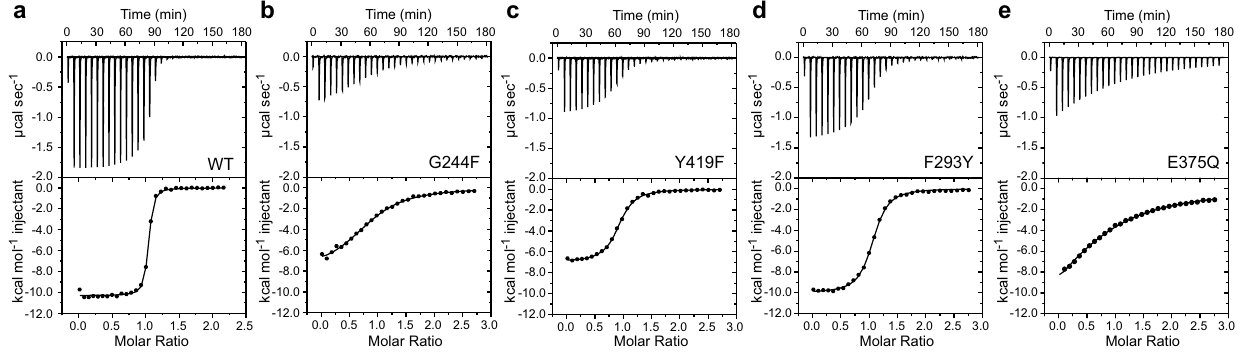
Fig. 3 | Thermodynamics ofET binding to wild-type and mutant Sp EgtUCs.a – e Thermograms and representative ITC-derived ET binding curves obtained for WT andindicatedmutantEgtUCs.Thecontinuouslinesshowthebest fi ttoasingle-site